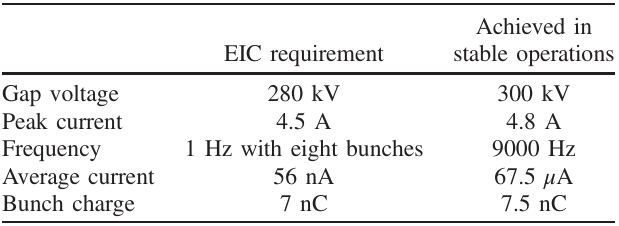
TABLE II. EIC polarized electron source requirement and the R&D gun achieved value.